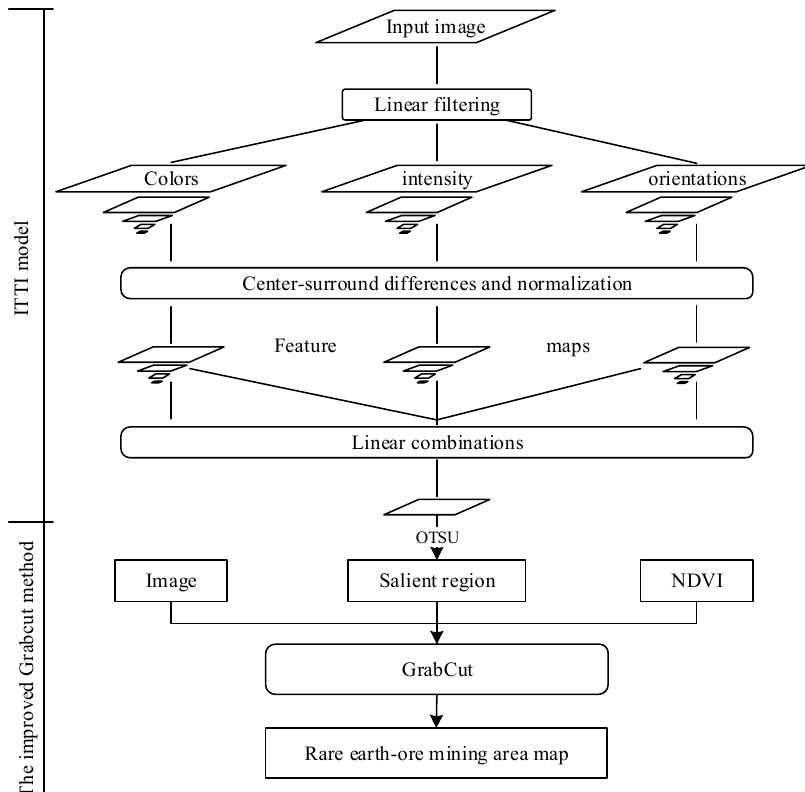
Figure 3. Flowchart of REO (Rare-earth Ore) mining area detection methods.